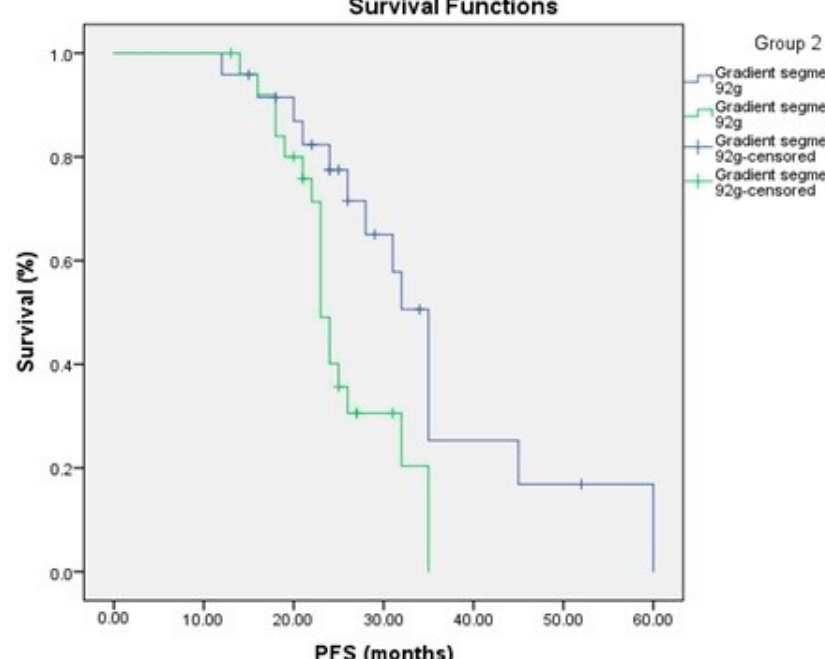
Figure 3. PFS in relation to FDG uptake. Table 3. Survival time means and medians.